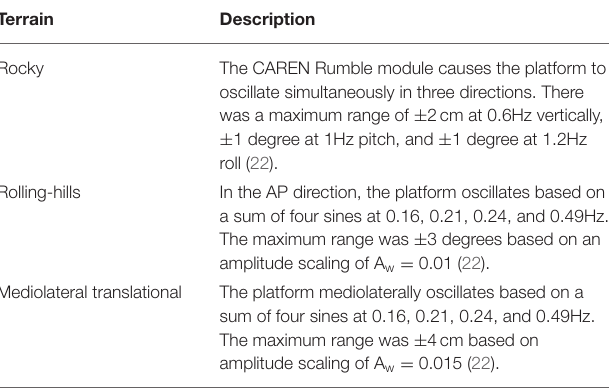
TABLE 1 | Destabilizing surfaces descriptions within the CAREN-Extended System.